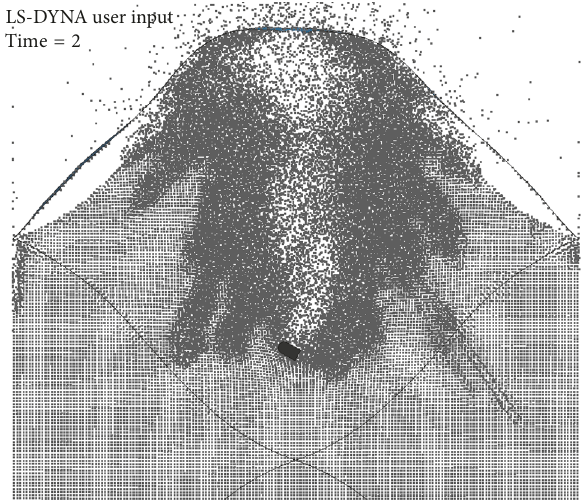
Figure 10: Penetration from middle-axis by MCPB.